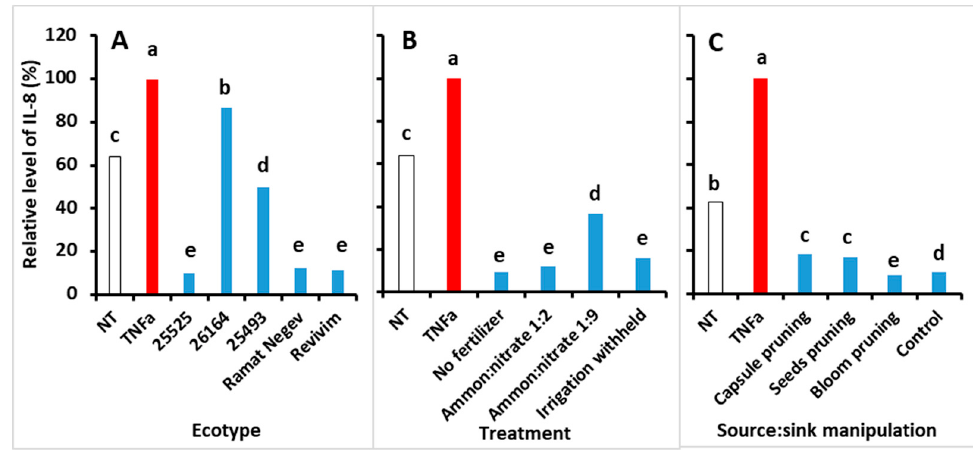
Figure 5. The relative level of IL-8 in HCT-116 cells treated with HSB tuber extracts of in different ecotypes ( A ), different mineral nutrition ( B ) and source-sink manipulations ( C ). Cells were treated with 50 ng/mL TNF α with or without HSB tuber extracts for 16 h. NT is the solvent (vehicle) control (7% v / v ethanol); TNF α is TNF α + solvent control treatment. Bars labeled with different letters are significantly different from all combinations of pairs according to the Tukey-Kramer HSD test ( p ≤ 0.05; n = 3).